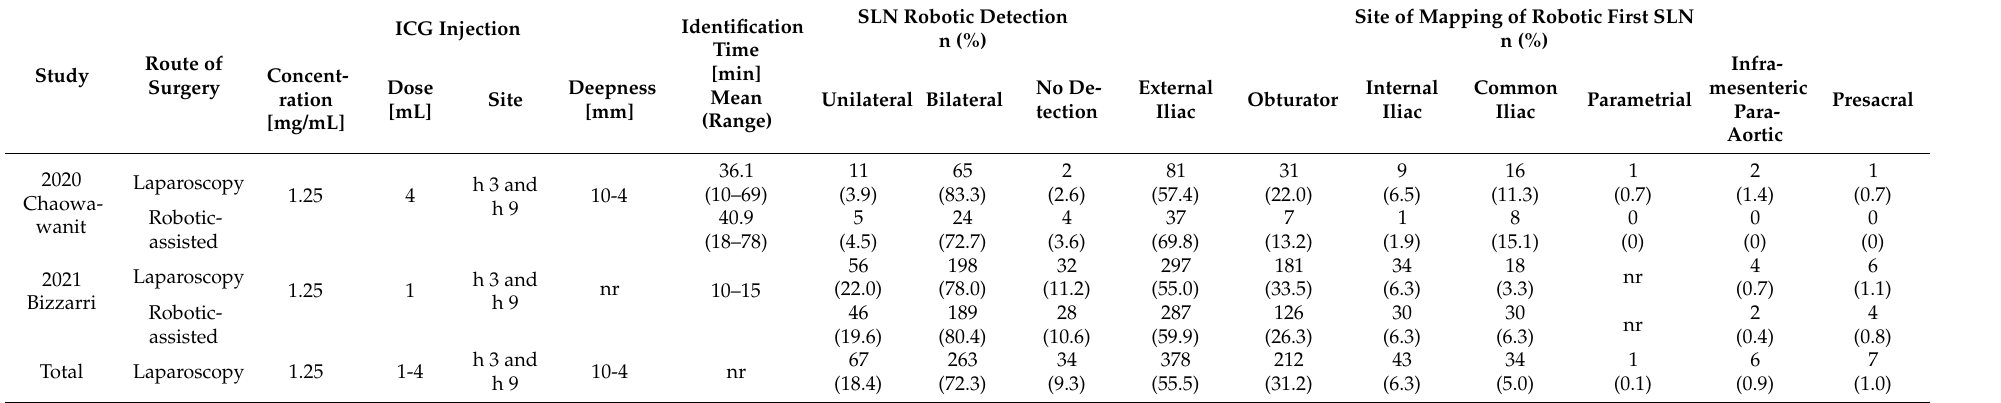
Table 3. Details about indocyanine green injection and lymph node detection and